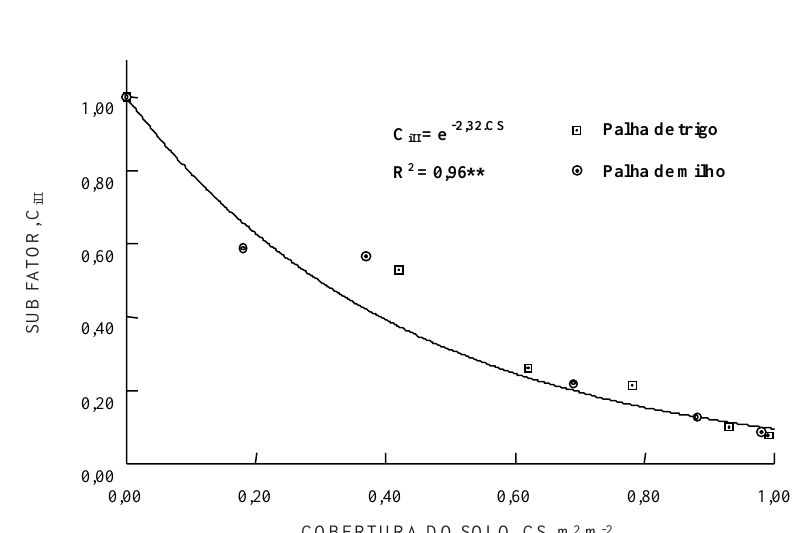
Figura 4. Subfator cobertura em contato direto com a superfície do solo (C do solo (CS) por diferentes quantidades de resíduos vegetais em entressulcos, segundo a equação (17), C = e -2,32CS iII